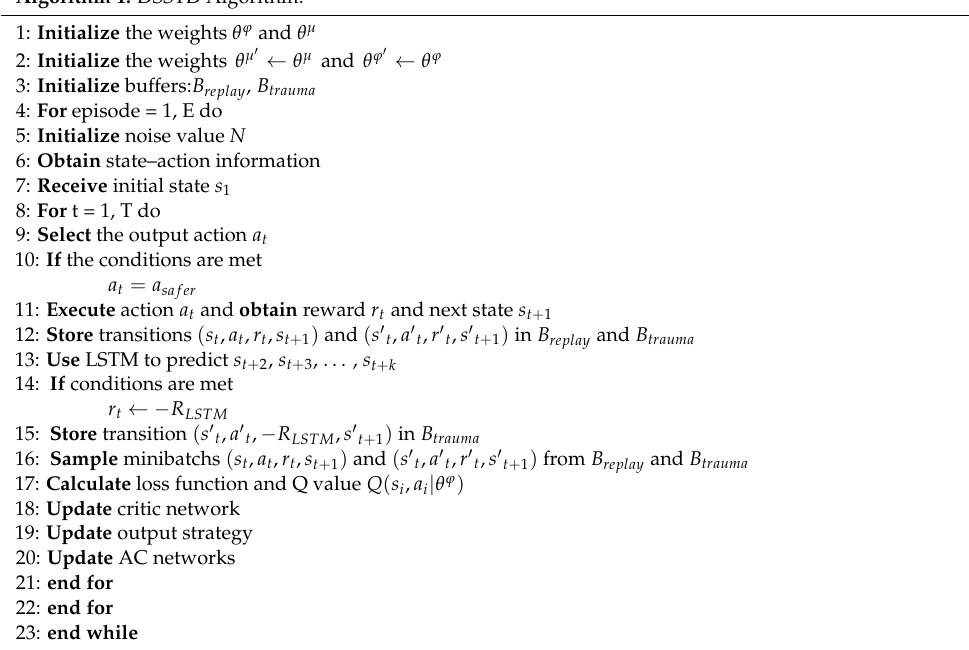
Algorithm 1. DSSTD